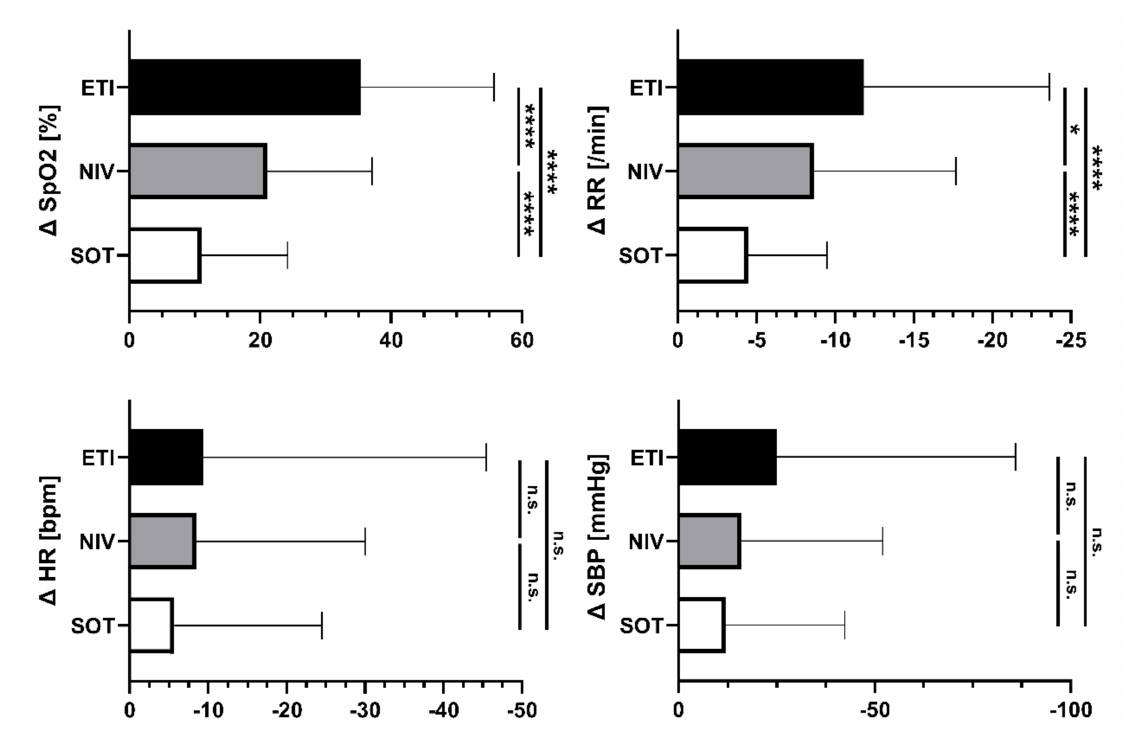
Figure 2. Absolute changes in respiratory and circulatory parameters at hospital admission in each study group. Data are presented as mean absolute change between first contact and hospital admission and standard deviation. A positive value on the x -axis shows an increase in the parameter and a negative value indicates a decrease; p > 0.05 = not significant (n.s.), p < 0.05 = *, p < 0.0001 = ****. Abbreviations: SpO 2 = saturation of peripheral oxygen, RR = respiratory rate, HR = heart rate, SBP = systolic blood pressure, SOT = standard oxygen therapy, NIV = non-invasive ventilation, ETI = endotracheal